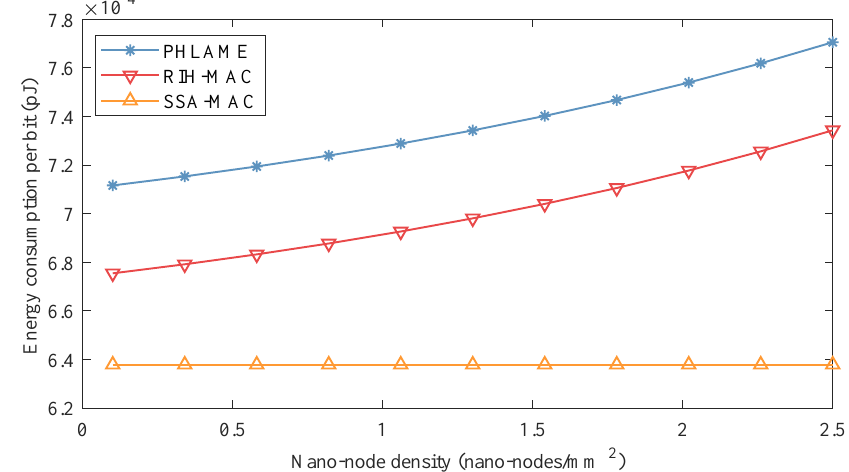
Figure 11. Energy consumption per bit of different MAC protocols as a function of nano-node density in distributed